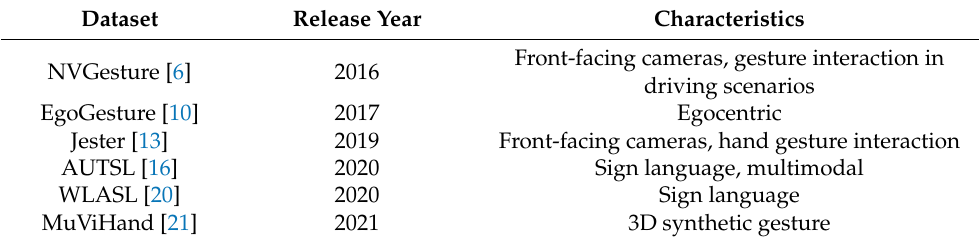
Table 1. Datasets for dynamic gesture